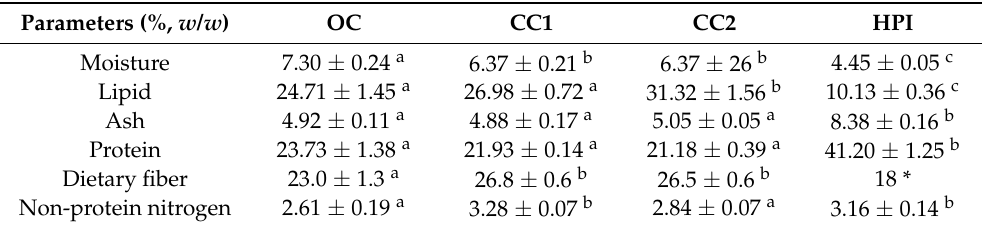
Table 1. Proximate analysis of one organically cultivated (OC) and two conventionally (CC1 and CC2) Finola variety hempseeds and a commercial hempseed protein isolate (HPI). Parameters (%, w / w